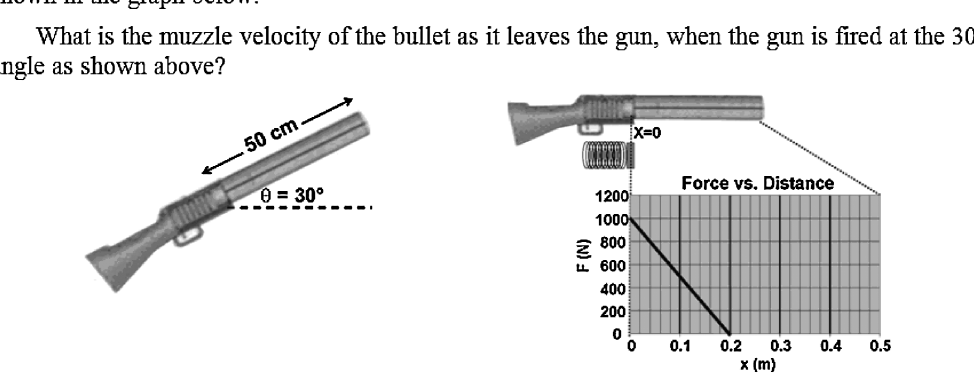
FIG. 1. The gun problem (interview